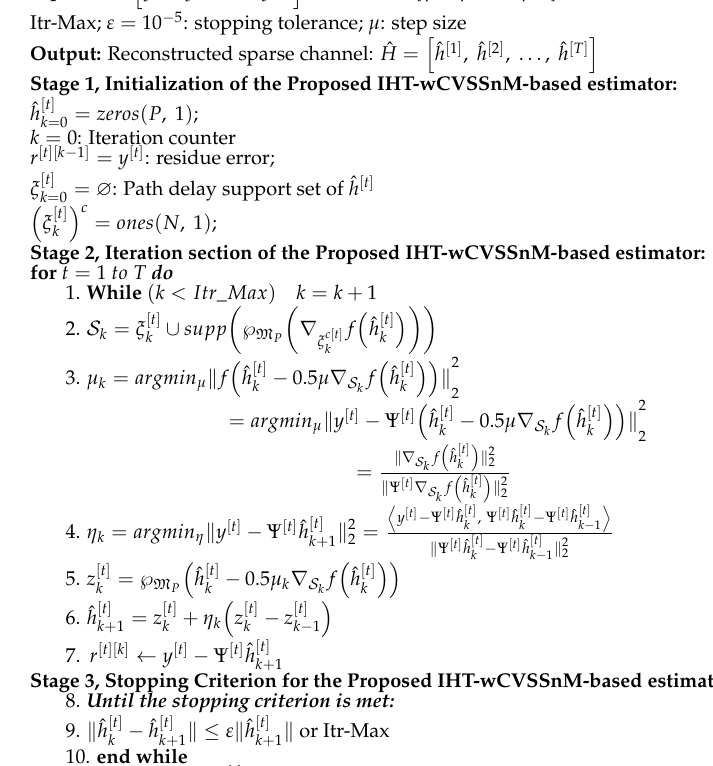
Linear Algorithm-based Estimator Traditional OMP-based Estimator